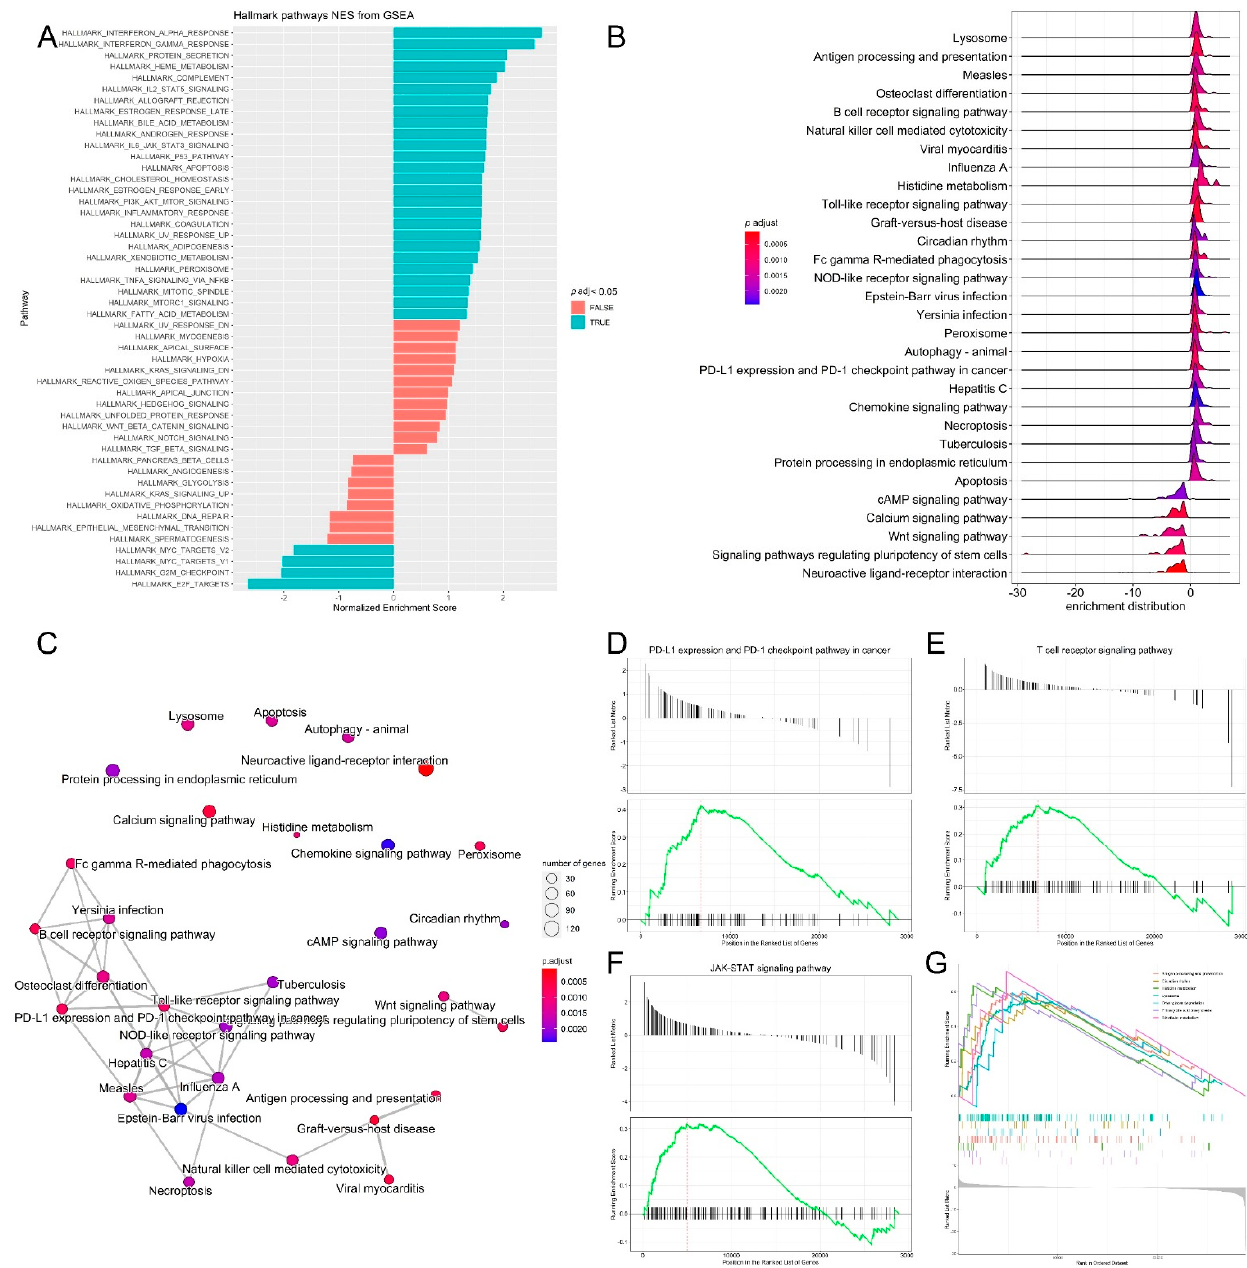
Figure 4. Pathway analysis, functional annotation of differentially expressed genes and identification of key regulatory genes of response to immunotherapy. ( A ) Barplot showing biological process terms and pathways of GSEA. GSEA-normalized enrichment scores are presented on the x -axis. ( B ) GSEA ridge plot for differentially expressed genes; the gradient indicates low to high adjusted p values. ( C ) Functional enrichment analysis from GSEA results. Nodes represent each enriched gene set of canonical pathways. Downregulated molecules are shown in shades of blue and upregulated genes are shown in shades of red. ( D – G ) Enrichment plots of top regulatory gene networks identified using gene set enrichment analysis. Significance was set at p -values ( ≤ 0.05) and false discovery rate ( ≤ 0.25). Enrichment plots show running enrichment score of the gene set as a running-sum statistic working down the ranked list of genes. Red–dashed line is the enrichment score peak of the plot for a specific gene set. Black–vertical bars are positions of genes in regulatory gene subnetworks in the ranked list of genes. Leading edge is a gene subset contributing mostly to enrichment scores and comprises the most differentially expressed